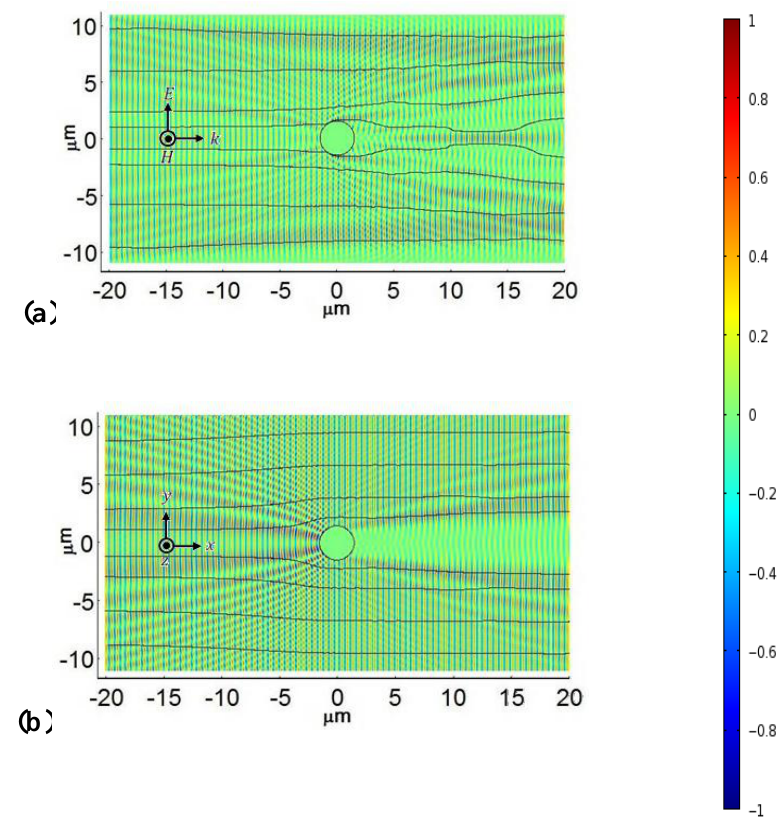
Figure 22. Simulated light propagation in a cylindrical cell with TM illumination at induces the radial profile of the extraordinary 𝜆 = 656 𝑛𝑚 . The applied voltage 200 V rms refractive index around central electrode and bends the trajectories of power flow around the electrode, mitigating its shadow (a) . At zero voltage, the cell has a spatially uniform refractive index (of toluene) and the electrode shadow is well pronounced (b) . The color represents the amplitude of magnetic field; see the scale on the right hand side.